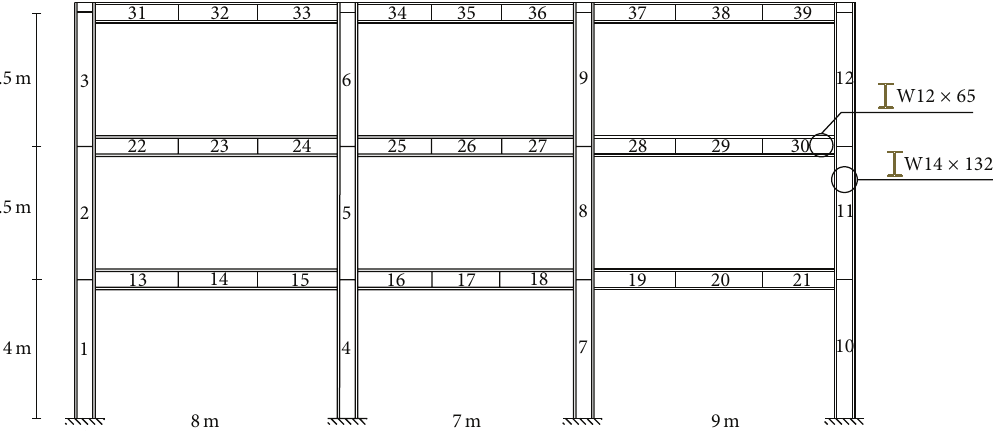
Figure 10: Geometry of unbraced plane frame.